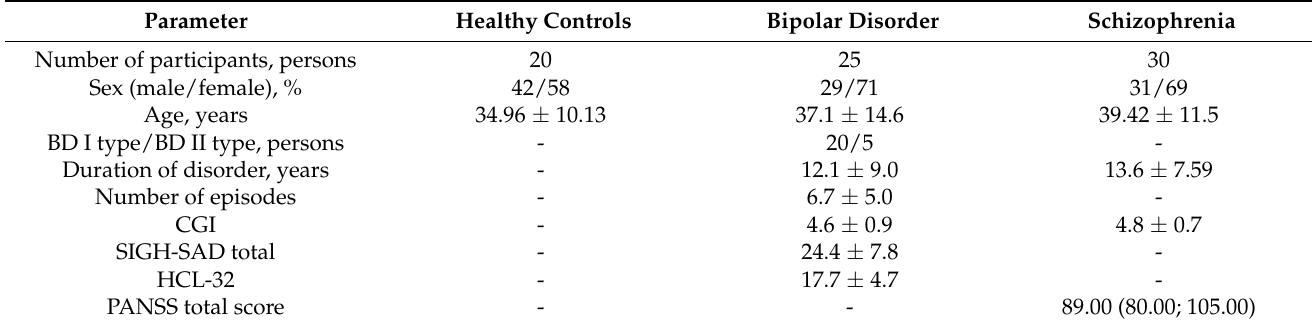
Table 1. Demographic and clinical characteristics of patients and healthy control